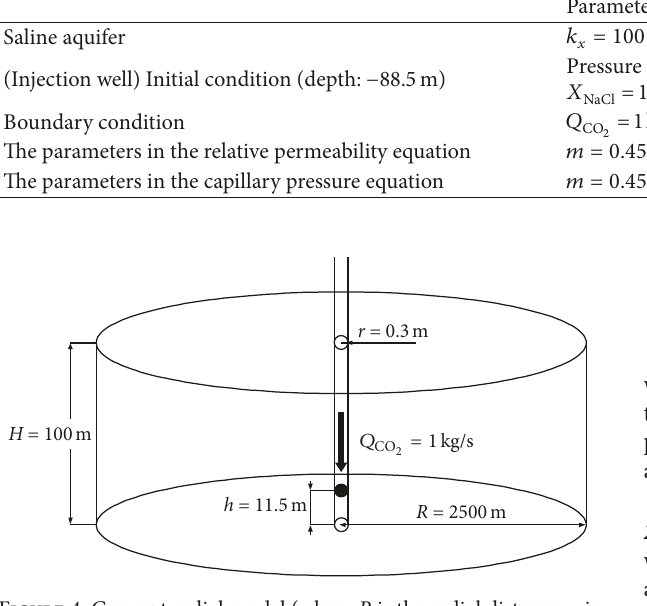
Figure 4: Concept radial model (where 𝑅 is the radial distance, 𝑟 is the radius of the injection well, ℎ is the distance from the injection well to the bottom, and 𝐻 is the thickness of the storage layer).